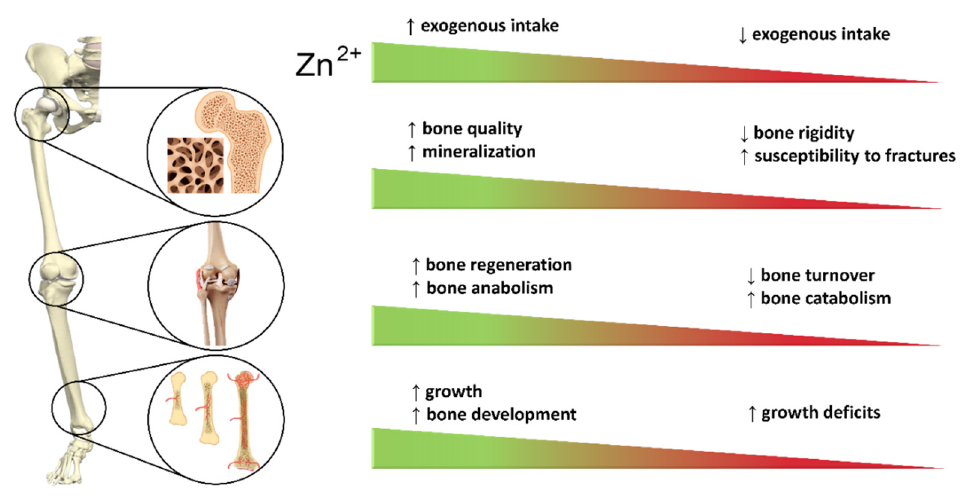
Figure 6. Effect of zinc intake (at high or low concentrations/doses) on the skeletal system.